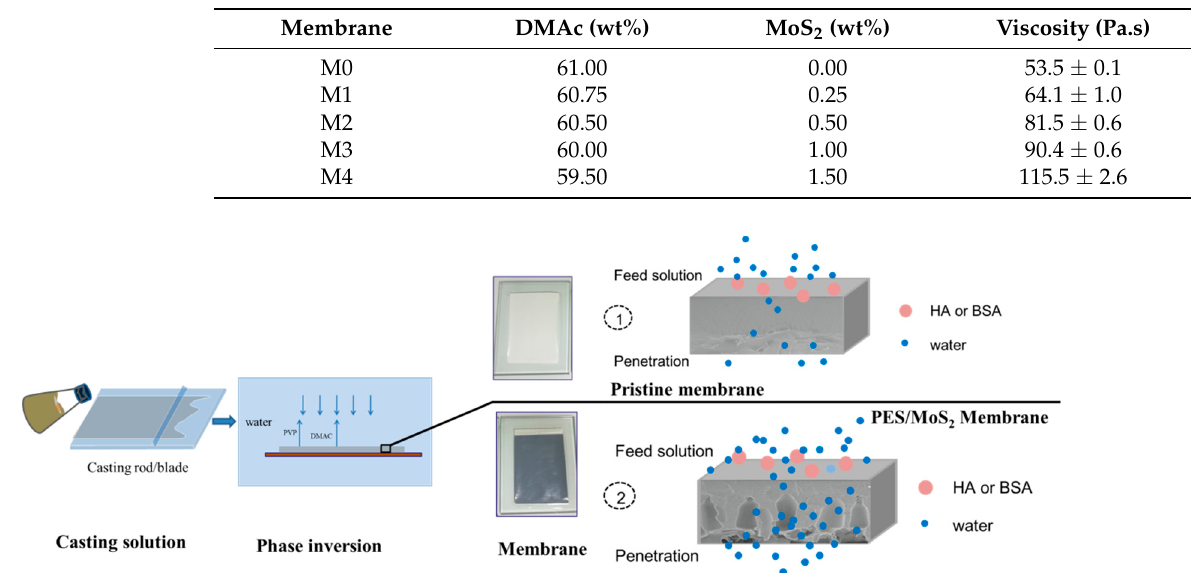
Figure 1. Synthesis and filtration process diagram of PES/MoS 2